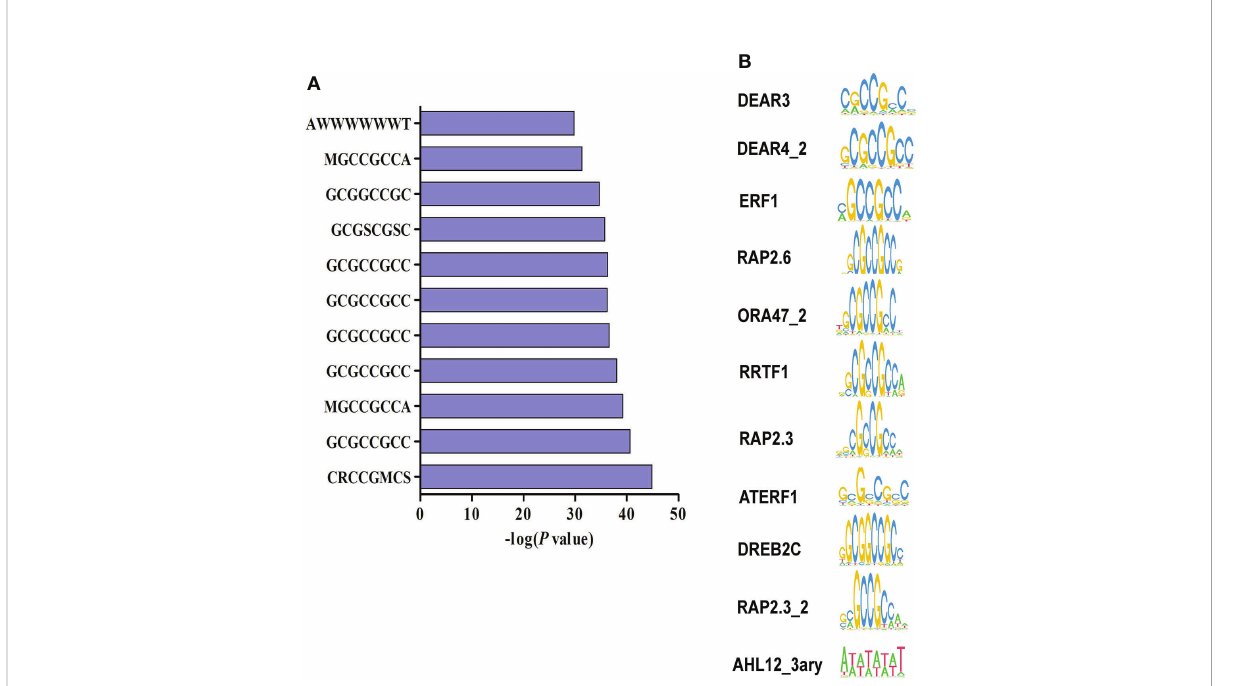
FIGURE 5 Identi fi cation of transcription factor binding motifs related to the repression of defense-related genes by HDAC. (A) Promoter motif enrichment analysis of 317 genes up-regulated by both rice blast infection and NaBT treatment. W represents for A or T, S represents for C or G, R represents for A or G, M represents for A or C. (B) The motifs enriched in the promoters of 317